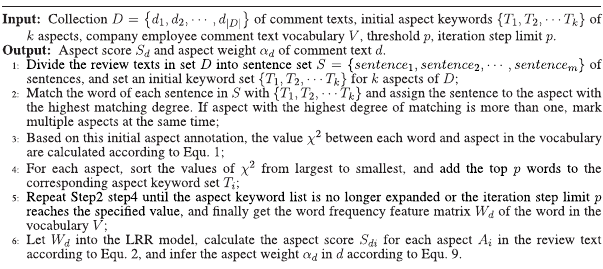
Algorithm 1. The framework of the joint